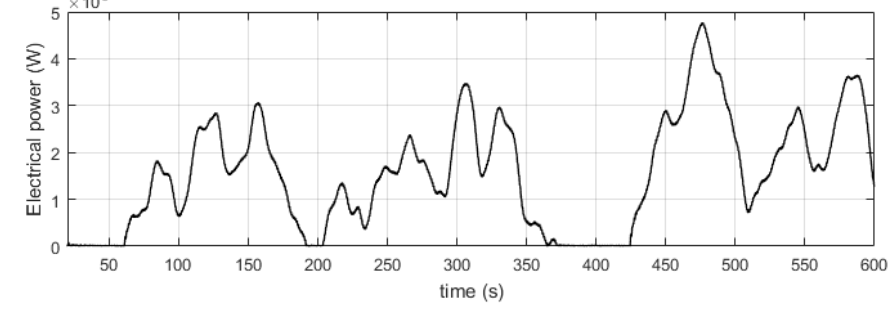
Figure 14. The power generated by the gas turbine.